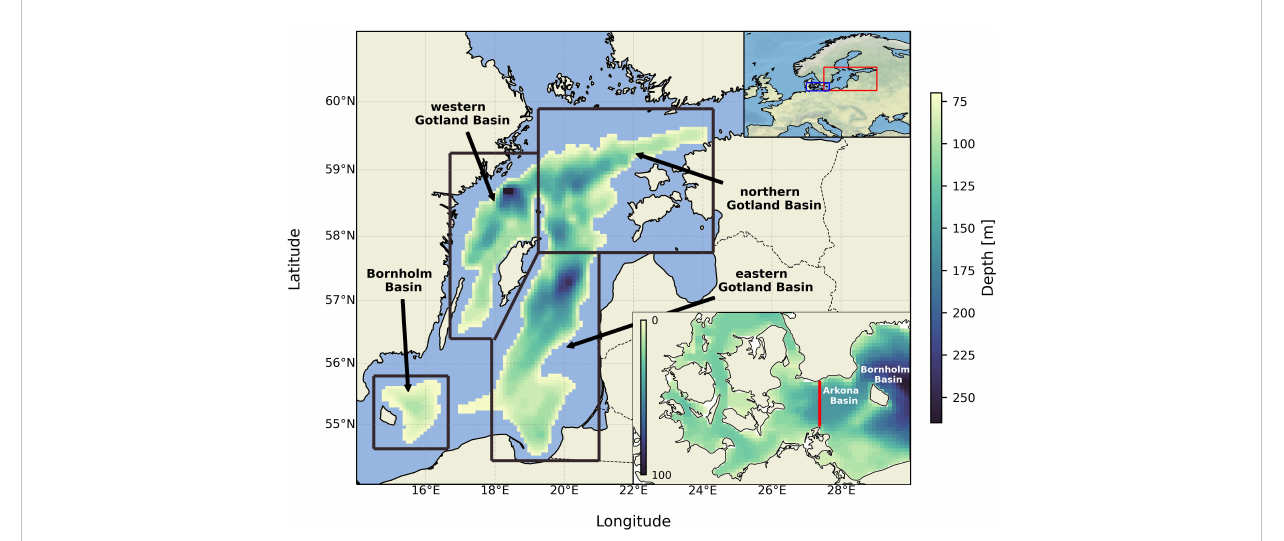
FIGURE 1 Model domain and boxes at 70 meters depth (boxes ’ upper boundary). The transect used for in fl ow detection is shown in the lower right panel. The locations of the study area and the area from the lower right panel are shown on the upper right panel (red and blue boxes,